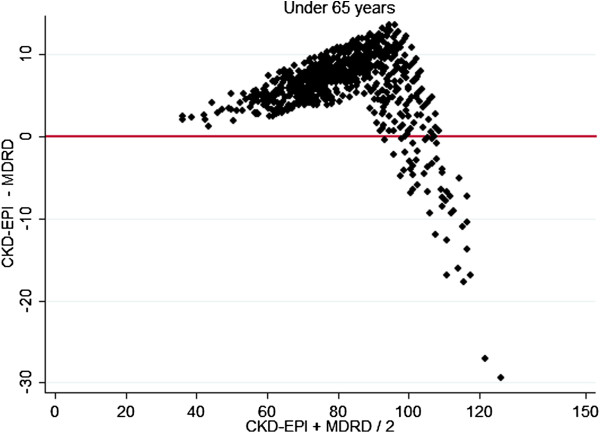
Bland Altman Plots (X axis mean CKD-EPI, MDRD, Y axis CKD-EPI − MDRD) in Subjects under 65 years.